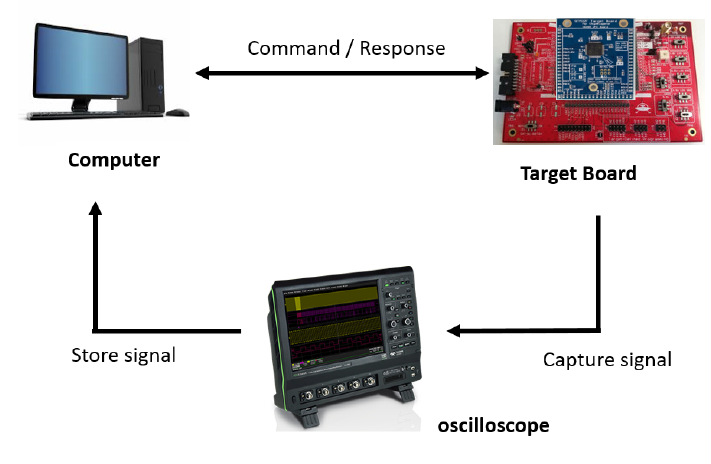
Figure 1. The scheme of the experimental setup used for measuring power